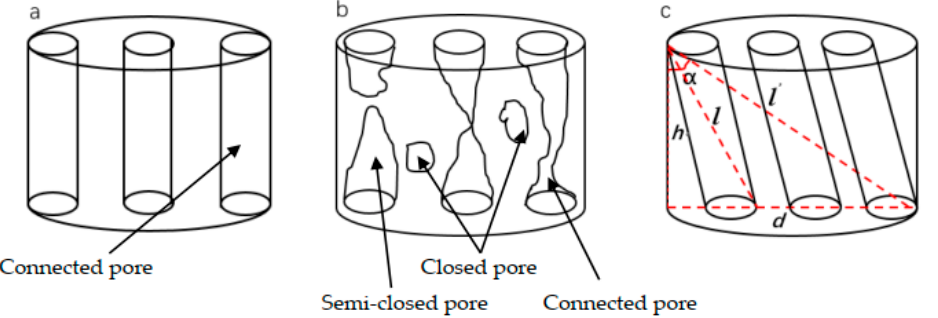
Figure 11. Pervious concrete percolation channels.